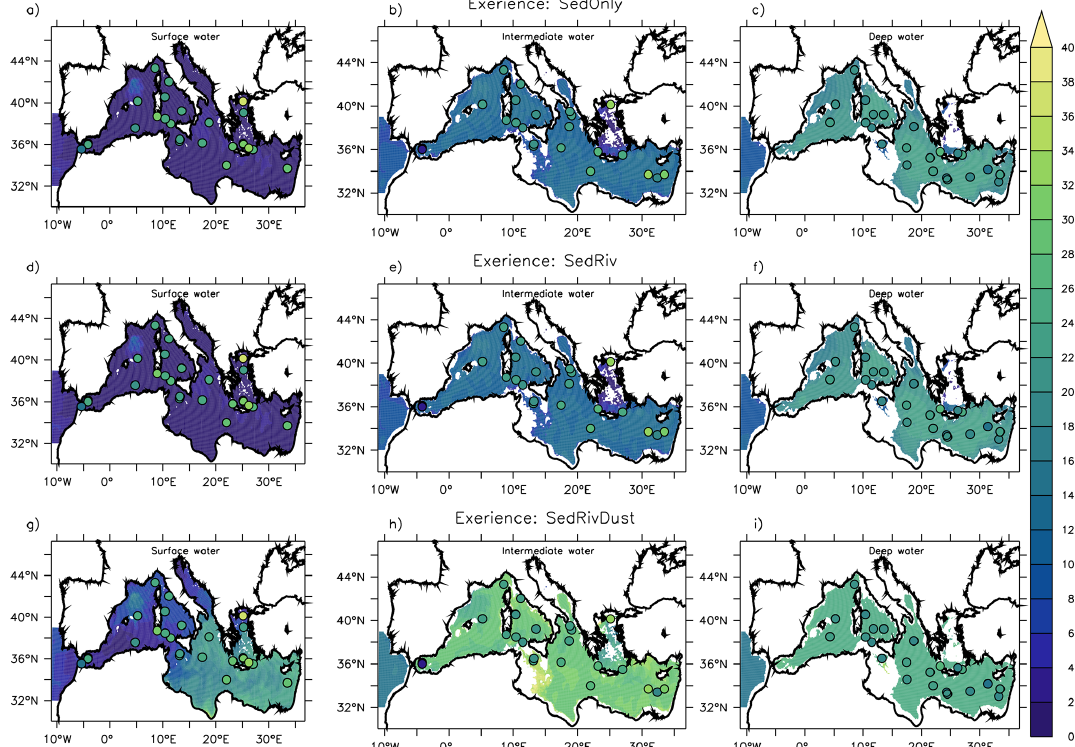
Figure 3. Horizontal maps of Nd concentration (in pmol/mol) averaged over the depth ranges of surface layer (0–200m; left column), intermediate layer (250–600m; middle column), and deep layer (600–3500m; right column). Results from SedOnly experiment with only sediment remobilisation (a, b, c) , SedRiv experiment with sediment and river input (d, e, f) , and SedRivDust experiment with inputs from sediment, river, and atmospheric dusts (g, h, i) . Colour-filled dots represent in situ observations from (Tachikawa et al., 2004; Vance et al., 2004; Henry et al., 1994; Dubois-Dauphin et al., 2017; Garcia-Solsona and Jeandel, 2020; Montagna et al., 2022). Both model and in situ data use the same colour